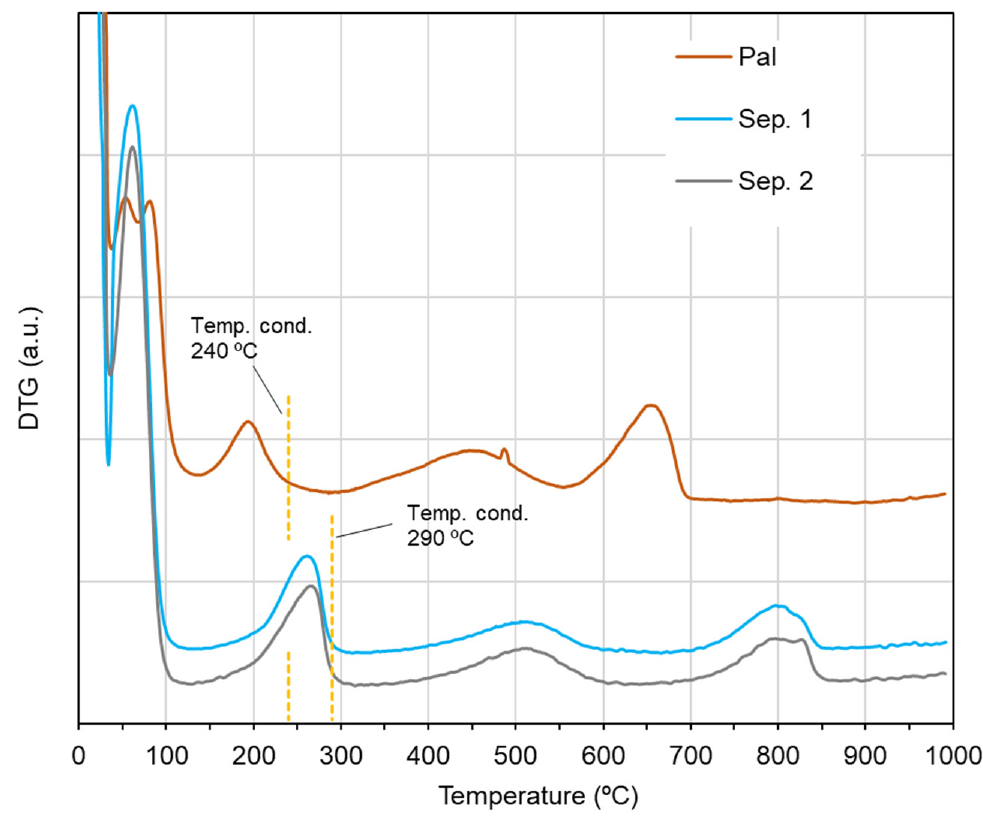
Figure 2. Derivative of the thermogravimetry (DTG) for the sepiolite and palygorskite samples.